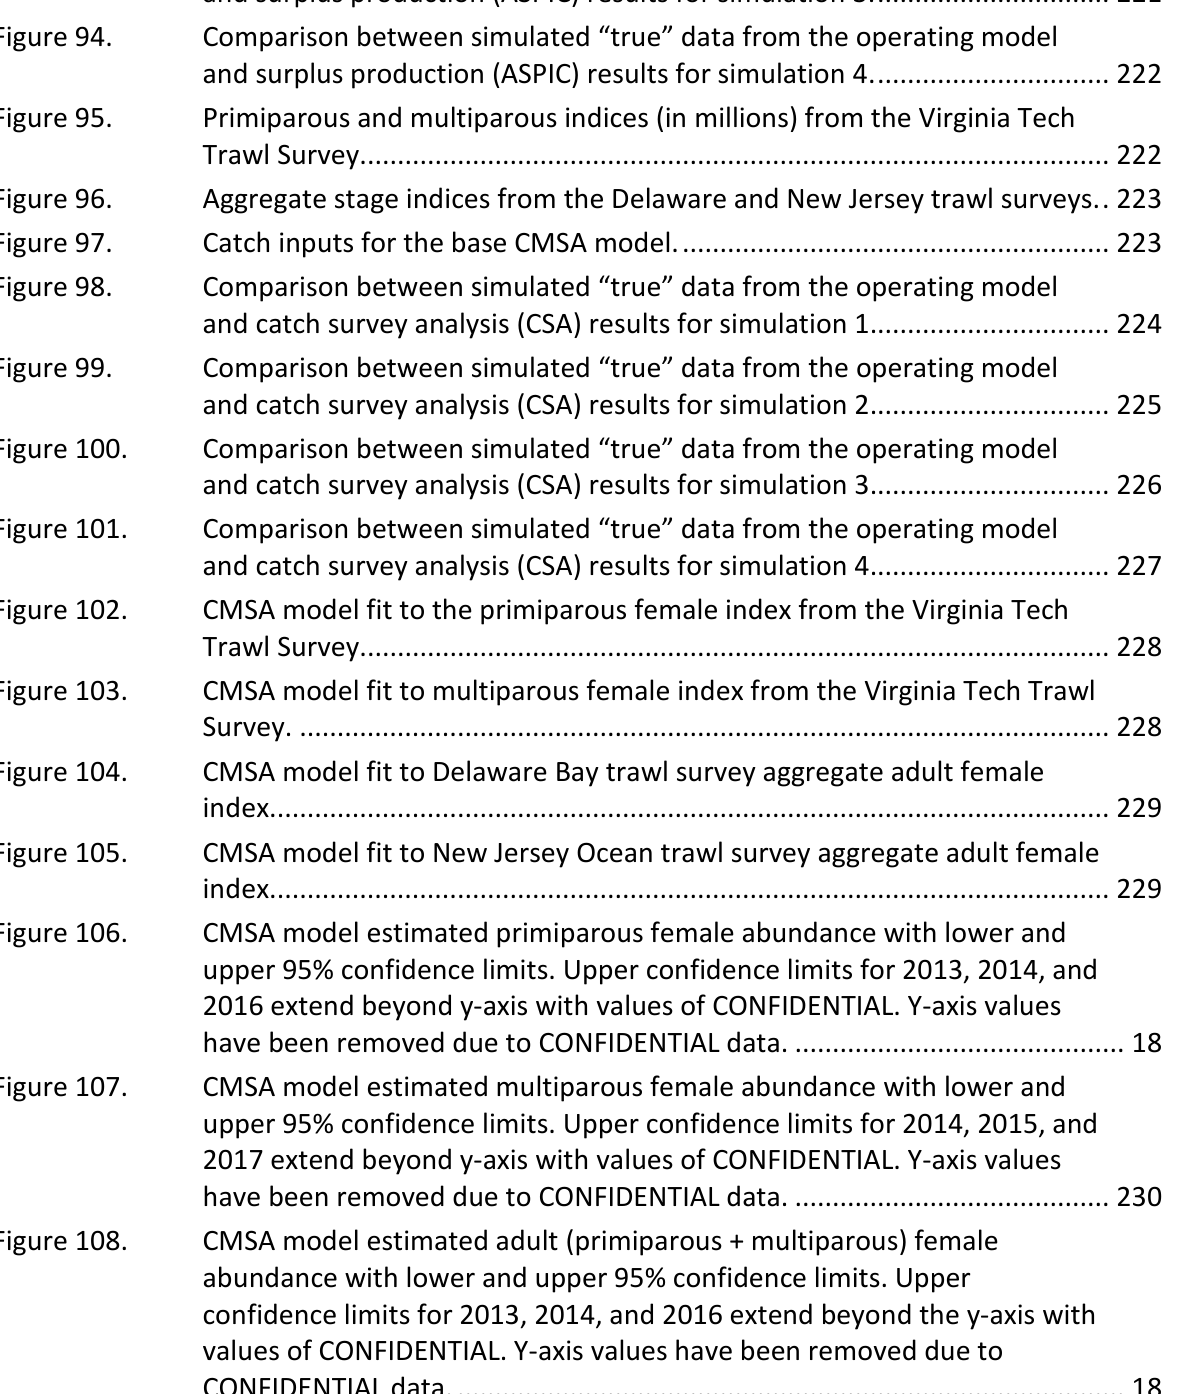
Figure 92. Comparison between simulated “true” data from the operating model and surplus production (ASPIC) results for simulation 2. ............................... 220 Figure 93. Comparison between simulated “true” data from the operating model and surplus production (ASPIC) results for simulation 3. ............................... 221 Figure 94. Comparison between simulated “true” data from the operating model and surplus production (ASPIC) results for simulation 4. ............................... 222 Figure 95. Primiparous and multiparous indices (in millions) from the Virginia Tech Trawl Survey. ................................................................................................... 222 Figure 96. Aggregate stage indices from the Delaware and New Jersey trawl surveys. . 223 Figure 97. Catch inputs for the base CMSA model. ......................................................... 223 Figure 98. Comparison between simulated “true” data from the operating model and catch survey analysis (CSA) results for simulation 1................................ 224 Figure 99. Comparison between simulated “true” data from the operating model and catch survey analysis (CSA) results for simulation 2................................ 225 Figure 100. Comparison between simulated “true” data from the operating model and catch survey analysis (CSA) results for simulation 3................................ 226 Figure 101. Comparison between simulated “true” data from the operating model and catch survey analysis (CSA) results for simulation 4................................ 227 Figure 102. CMSA model fit to the primiparous female index from the Virginia Tech Figure 103. CMSA model fit to multiparous female index from the Virginia Tech Trawl Figure 104. CMSA model fit to Delaware Bay trawl survey aggregate adult female Figure 105. CMSA model fit to New Jersey Ocean trawl survey aggregate adult female Figure 106. CMSA model estimated primiparous female abundance with lower and upper 95% confidence limits. Upper confidence limits for 2013, 2014, and 2016 extend beyond y-axis with values of CONFIDENTIAL. Y-axis values have been removed due to CONFIDENTIAL data. ............................................ 18 Figure 107. CMSA model estimated multiparous female abundance with lower and upper 95% confidence limits. Upper confidence limits for 2014, 2015, and 2017 extend beyond y-axis with values of CONFIDENTIAL. Y-axis values have been removed due to CONFIDENTIAL data. .......................................... 230 Figure 108. CMSA model estimated adult (primiparous + multiparous) female abundance with lower and upper 95% confidence limits. Upper confidence limits for 2013, 2014, and 2016 extend beyond the y-axis with values of CONFIDENTIAL. Y-axis values have been removed due